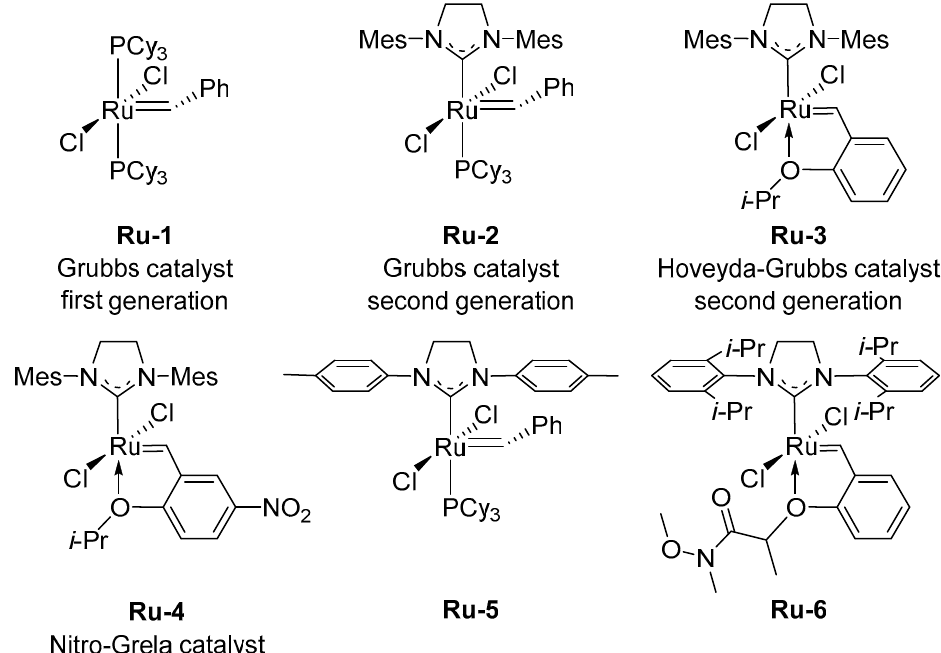
Figure 1. Ruthenium-based olefin metathesis catalysts referred to in this review.